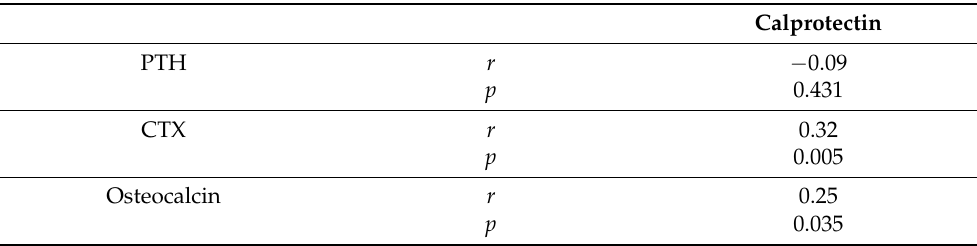
Table 4. Correlation between concentration of calprotectin and PTH and bone mineral markers (CTX and osteocalcin).